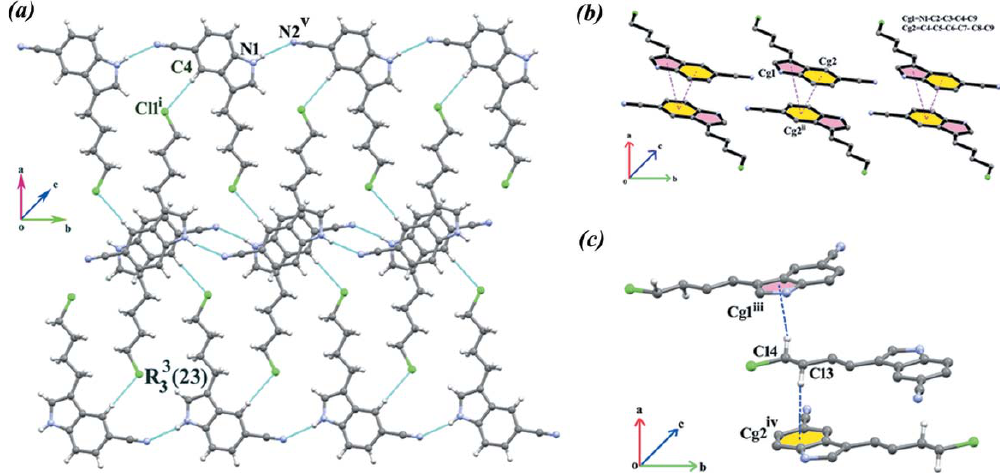
Figure 2 A view of two-dimensional supramolecular sheet via N—H (cid:2)(cid:2)(cid:2) N and weak intermolecular C—H (cid:2)(cid:2)(cid:2) Cl hydrogen bonding, aromatic (cid:4) – (cid:4) and weak C—H (cid:2)(cid:2)(cid:2) (cid:4) interactions. [Symmetry codes: (i) 1 (cid:4) x , (cid:4) 1